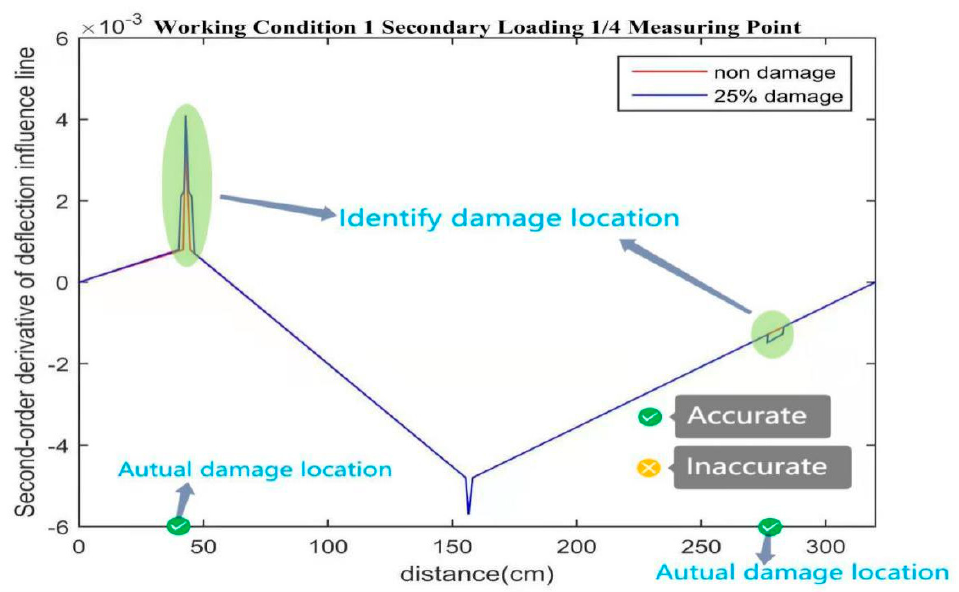
Figure 32. The second derivative of deflection influence the line at 1/4 determining point of the first span following work condition 4.